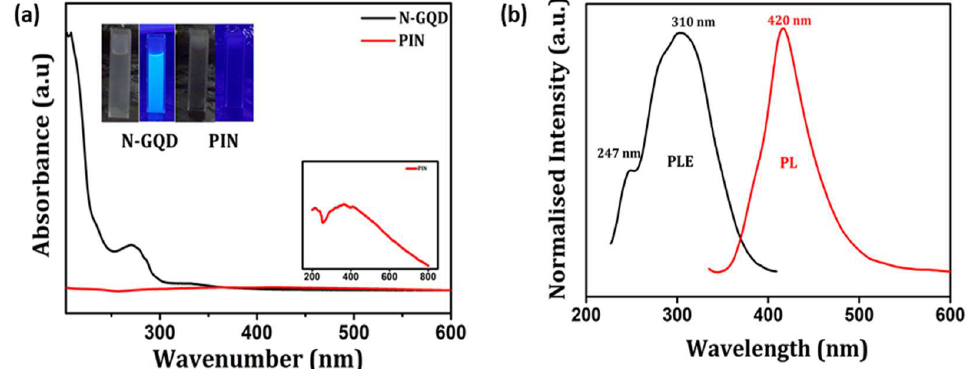
Figure 3. ( a ) UV–vis spectra of PIN and N-GQDs; ( b ) PL and PLE spectrum of N-GQDs. The inset in ( a ) (left top) displays the photographs of PIN (right) and N-GQD (left) under visible light and at 365 nm UV irradiation. The right inset in ( a ) shows enlarged UV–vis spectra of PIN.